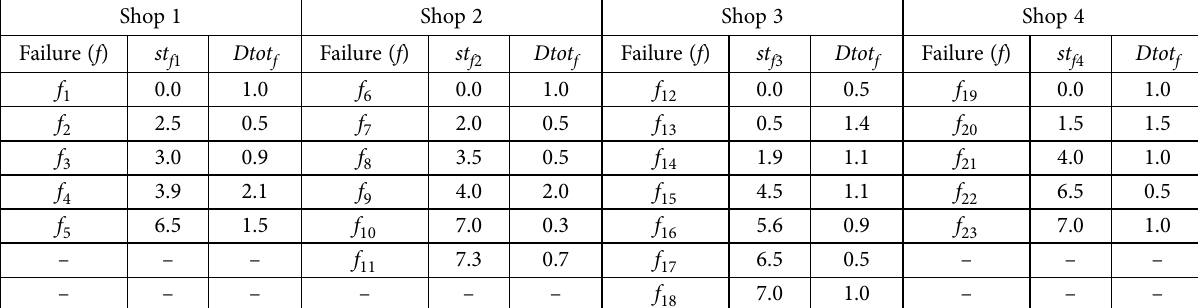
Table 7. The pre-established repairs schedule of regular failures on the day of emergency